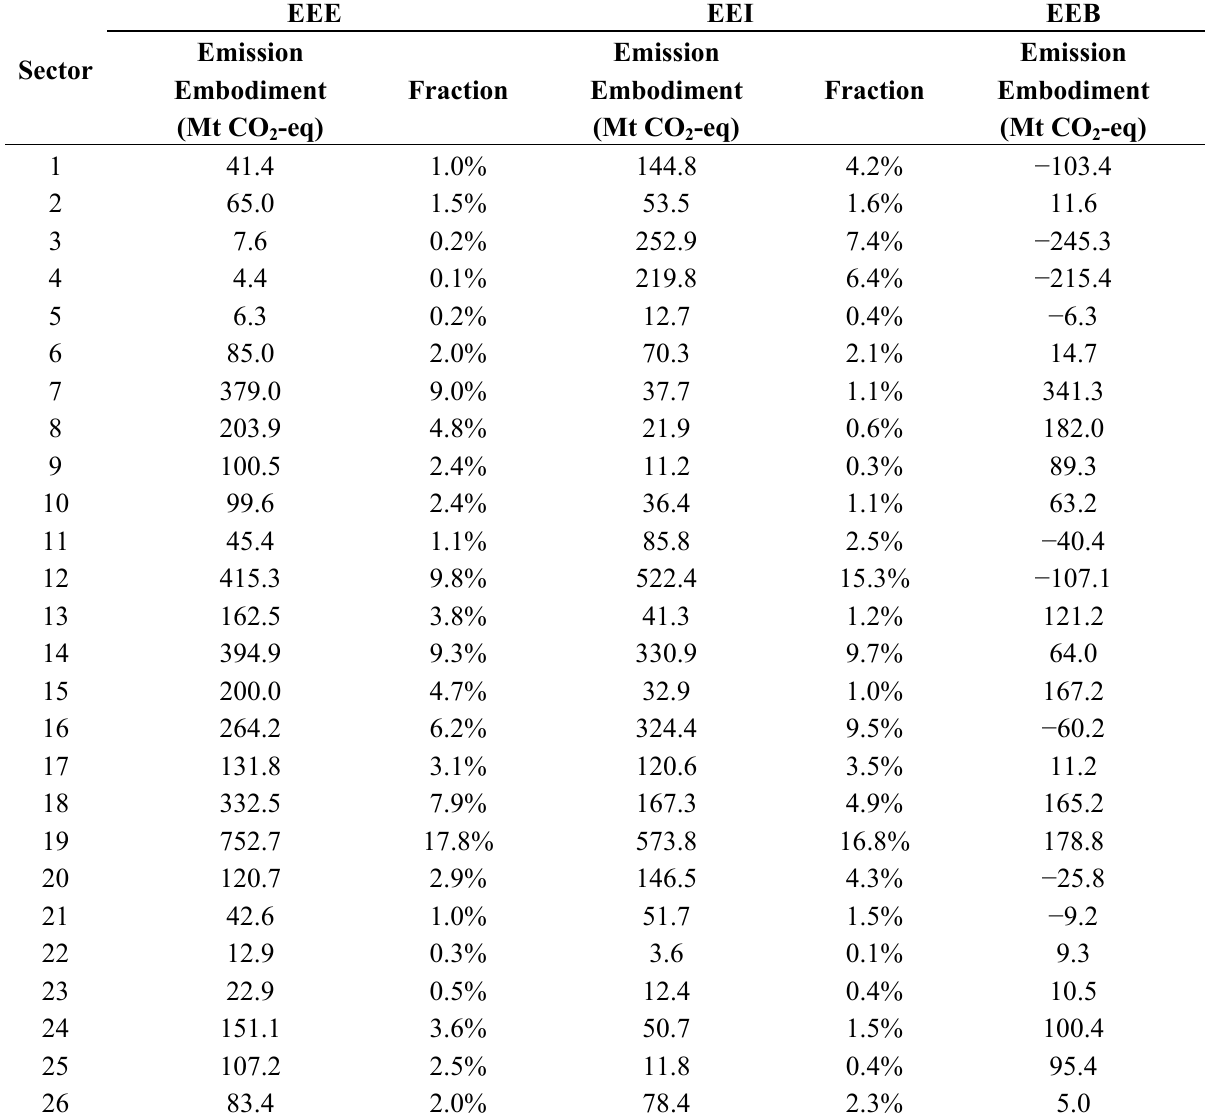
Table 6. Distribution of embodied GHG emissions in international trade by